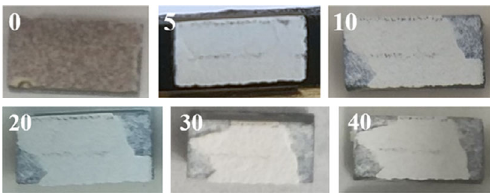
Fig. 8 Images of Al 2 O 3 –YSZ coatings during thermal cycling.